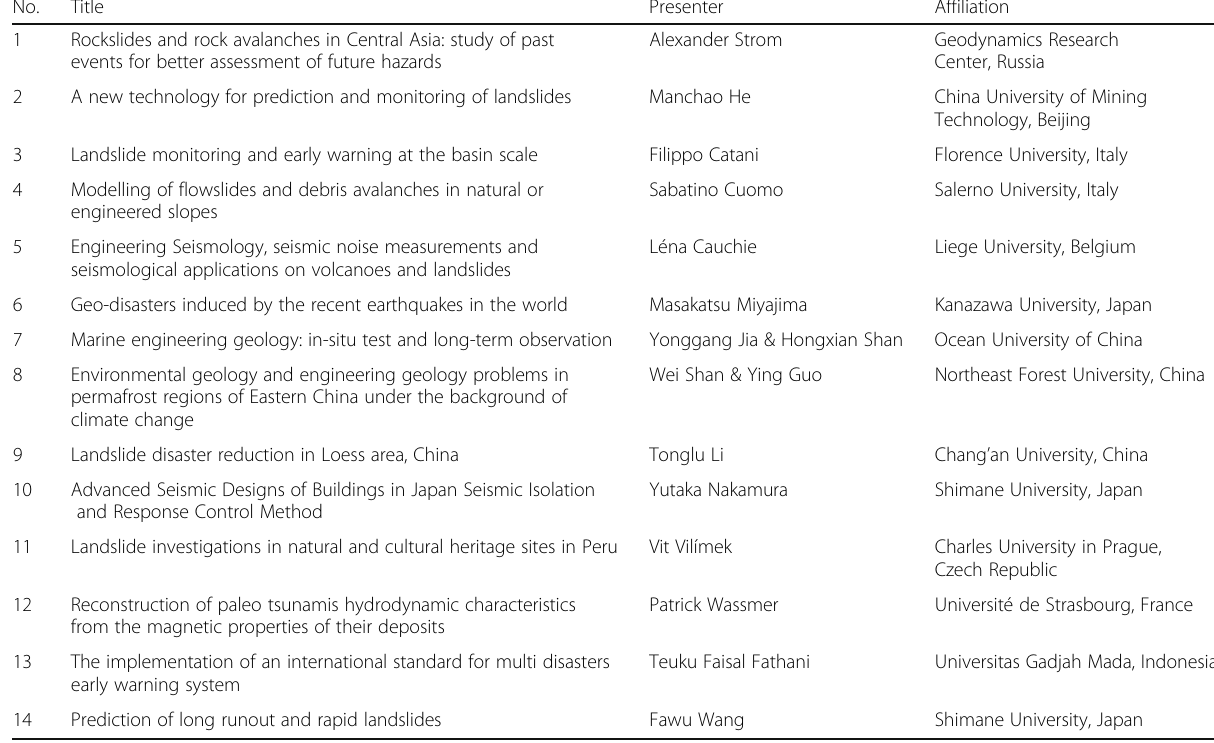
Table 1 Lists of the presentation in the UNESCO Chair 2019 field school No.